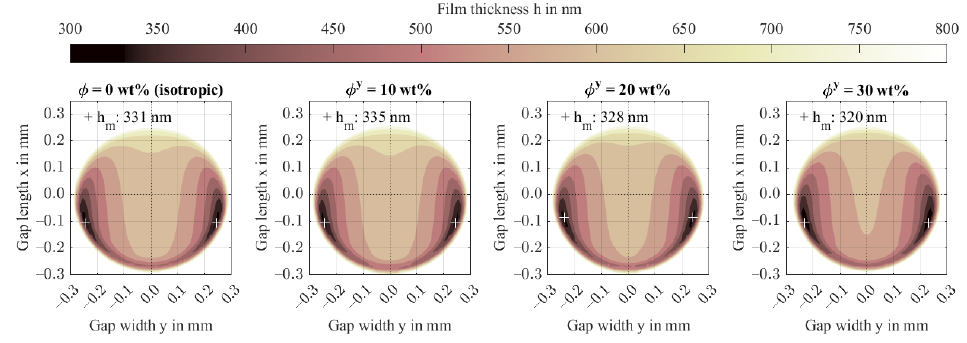
Figure 7. Film thickness contours including minima for increasing fiber content in the y-direction φ y